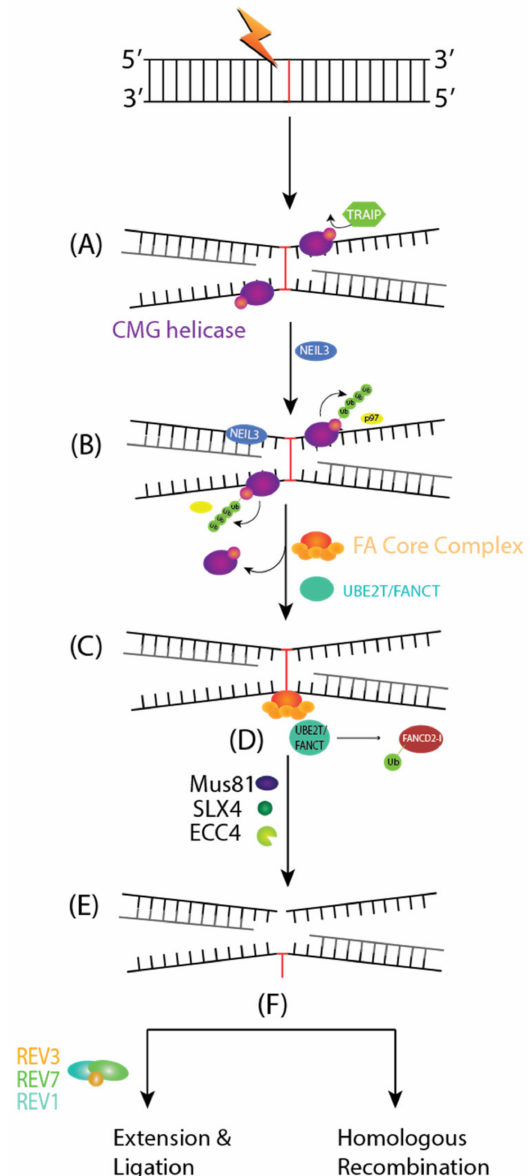
Figure 4. Fanconi Anemia (FA) Pathway of Interstrand Crosslinks (ICLs). ( A ) ICLs occurring during the S phase of the cell cycle will converge two replication forks creating an X-shaped structure surrounding it. TRAIP will ubiquitinate CMG helicase to recruit NEIL3 Glycosylase for an incision- dependent unhooking mechanism of ICL resolution. ( B ) Subsequently, CMG is evicted from the chromatin through long Ub chains and p97, allowing for the approach of both replication forks towards the ICL. This commits the repair to FA pathway-mediated ICL repair. ( C ) The FA Core Complex is recruited to the chromatin through UHRF1 and FANCM-MHF1-MHF2 complex (not depicted). ( D ) The FA Core Complex and UBE2T/FANCT E2 conjugating enzymes will monoubiqui- tinate FANCD2-I. FANCD2-I will recruit Mus81, SLX4, and ERCC4 endonucleases ( E ) to cleave the DNA strand contiguous to the ICL and generate a DNA adduct and an ICL-derived DSB. ( F ) The DNA adduct is bypassed by REV1, REV7/FANCV, and REV3 and a DSB will be repaired through HR,